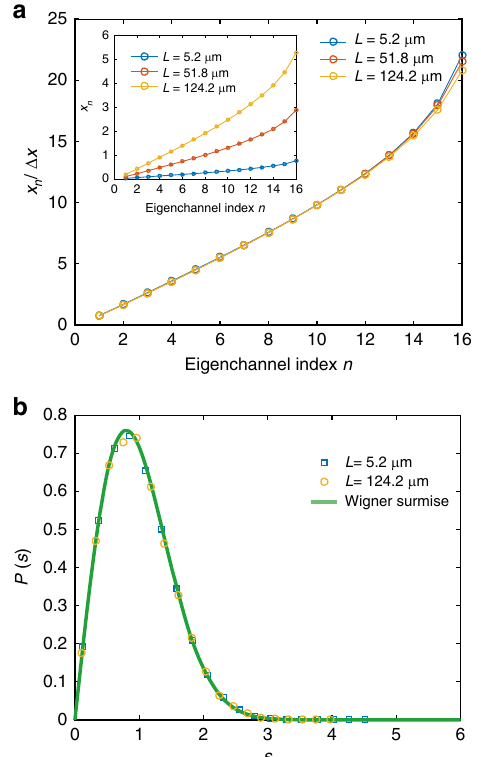
Fig. 3 Structure of the transmission eigenvalues. The x n are determined by the transmission eigenvalues via the expression, τ n = 1/cosh 2 x n with x n = L / ξ n . a The variation of the x n relative to the average spacing between them, Δ x , are similar for different sample lengths, L . b The probability distribution of the spacing between the x n for n < N /2 in individual con fi gurations is in accord with the Wigner surmise 27 for the eigenvalues of large random matrices for the Gaussian orthogonal ensemble, P ð s Þ ¼ π e (cid:2) π s 2 = 4 for both 2 translucent and diffusive samples Fig. 2 Scaling of total transmission. a Measurements of the scaling of the inverse of the optical transmission through a dilute suspension of 0.17- μ m- diameter latex spheres in water. A photograph of the face of the translucent sample with a wedge angle of 0.86° is shown. The thicknesses at the beginning and end of the scan are indicated by the dashed green lines. The sides of the wedge are not shown because the microscope slides forming the faces of the sample are attached at their sides to a glass wedge with wax. The determination of ℓ ~ 0.9 mm is discussed in the text. The value of z fl ection at the air-glass interfaces. b b is increased due to surface re Simulations of the scaling of the inverse of the total transmission averaged over all incident channels extrapolates to zero at 2 z b , giving z b = 19.1 ± 0.1 μ m. The vertical solid line indicates L = 0 μ m and the vertical dashed line gives the value of ℓ s . c Results of simulations show a linear falloff of average energy density inside both translucent and multiple-scattering samples. The energy density extrapolates to zero beyond the sample boundary at the same distance z b = 19.2 ± 0.2 μ m in both samples. The output boundaries of the two samples are indicated by the dashed vertical